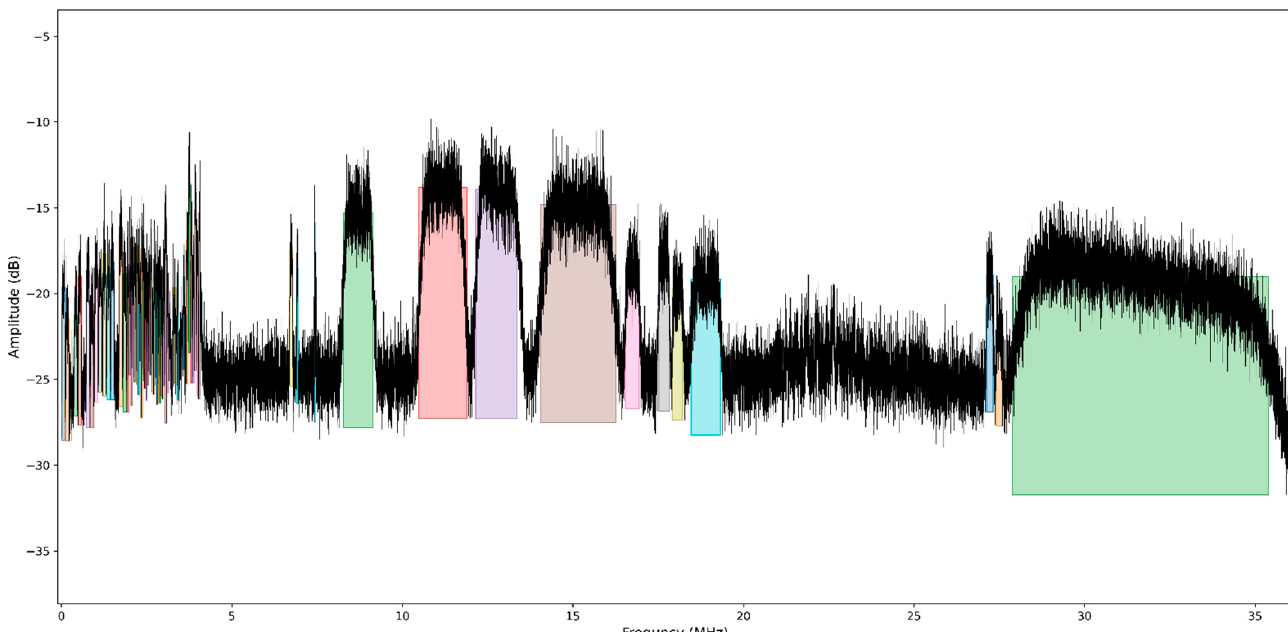
Figure A6. Example6 of the actual satellite broadband power spectrum set.